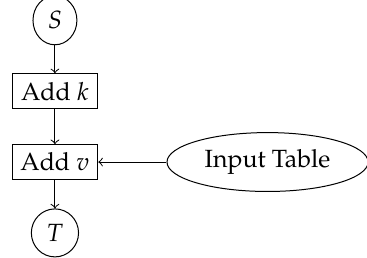
Figure 1. Example of a connected